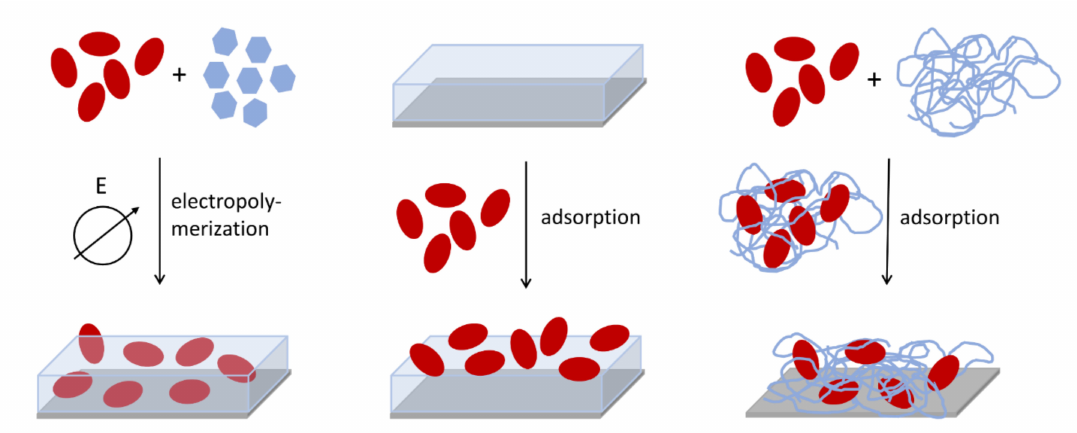
Schematic illustration of di ff erent ways of combining biomolecules and organic semiconductors for the fabrication of sensors: entrapment during electropolymerization or co-polymerization, adsorption to pre-polymerized films or adsorption of enzyme / polymer mixtures on the